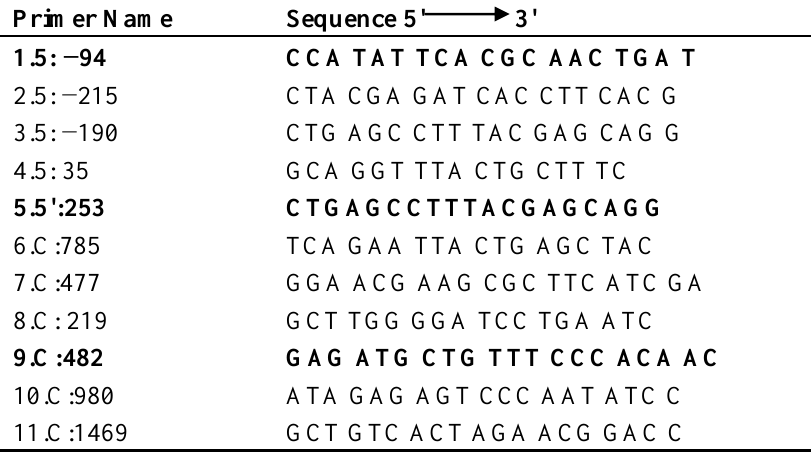
Table 1. Nucleotide sequence of primers that were used to detect the orf256 sequence using PCR. Primers with bold face font gave common positive PCR results with all tested